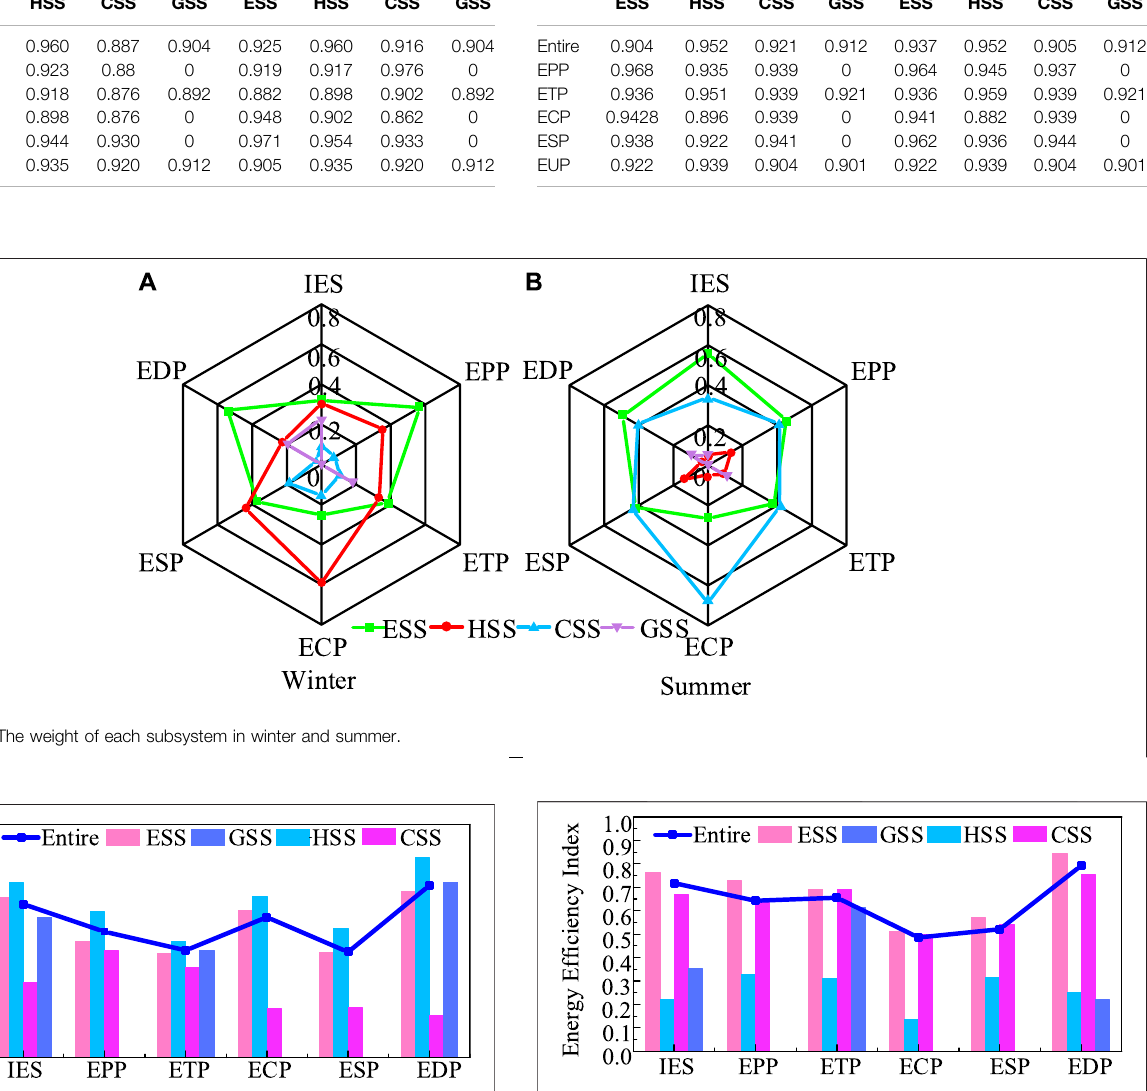
FIGURE 5 | The energy ef fi ciency evaluation results of the IES in winter. FIGURE 6 | The energy ef fi ciency evaluation results of the IES in